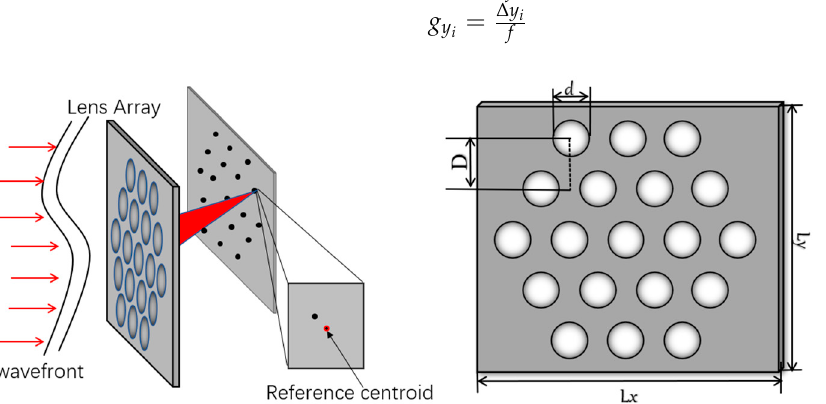
Figure 1. System structure diagram.